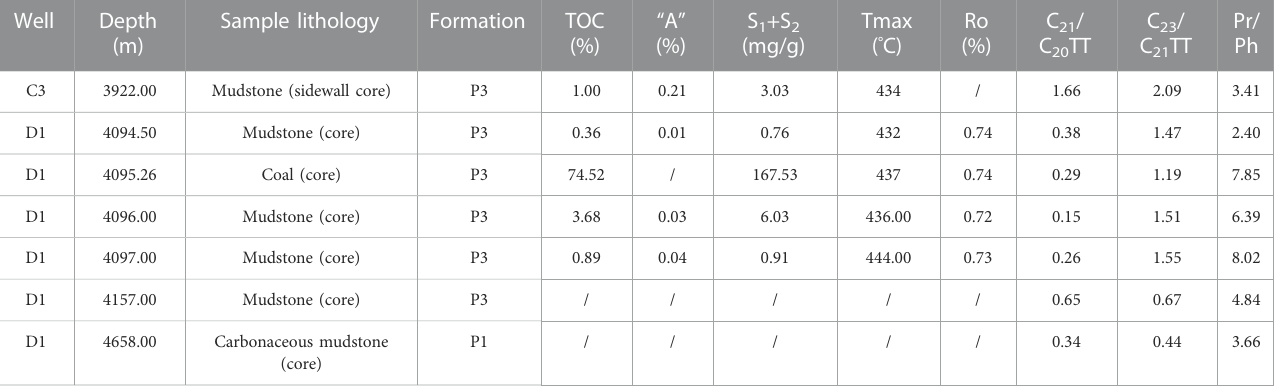
TABLE 3 ( Continued ) Geochemical data of sedimentary rock in the Pingbei area, East China Sea Basin.